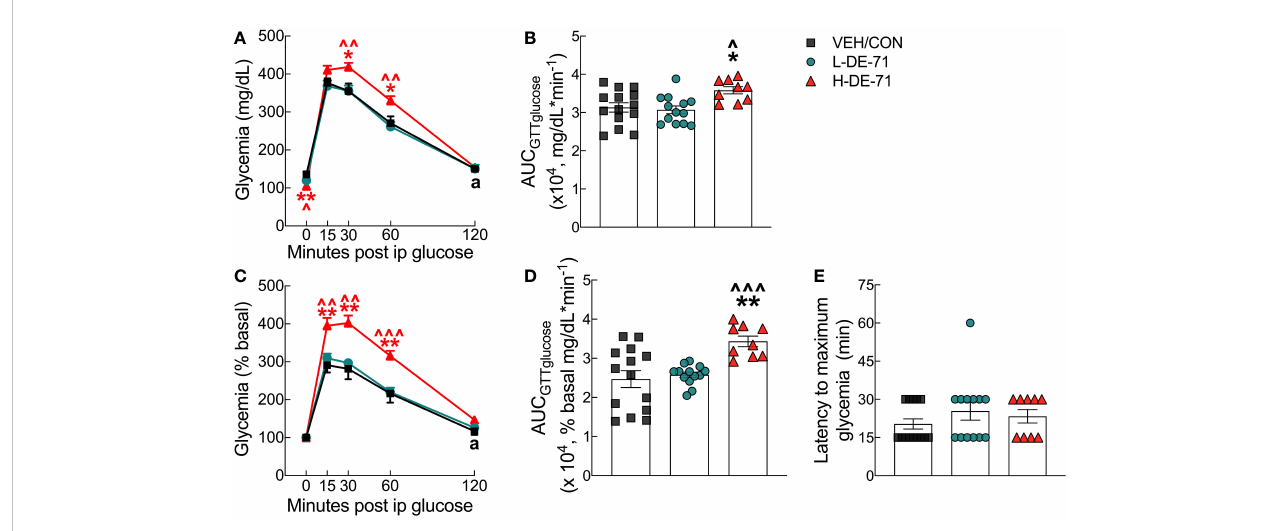
FIGURE 3 Glucose tolerance pro fi le in male mice offspring receiving perinatal exposure to DE-71. Mice were fasted for 11 h ON and tail blood was sampled for glucose before (t=0 min) and after (t=15, 30, 60 and 120 min) i.p. injection of 2.0 g/kg glucose. (A) Absolute blood glucose concentrations taken during IPGTT. (B) Mean values for the integrated area under the IPGTT glucose curve using absolute values (AUC GTTglucose ). (C) Blood glucose values taken during IPGTT are plotted vs time as a percent of basal glucose. (D) Mean values for the integrated area under the IPGTT glucose curve using percent baseline values (AUC GTTglucose ). (E) Latency to maximum glycemia corresponding to percent basal. Asterisk of speci fi c color indicates signi fi cant difference between corresponding group and VEH/CON (* p <0.05, ** p <0.01). Carets of speci fi c color indicate signi fi cant difference between corresponding group and L-DE-71 (^ p <0.05, ^^ p <0.01, ^^^ p <0.001). The black symbol “ a ” in panels (A, C) indicates the time points at which glycemia is not different from basal (t=0) in the VEH/CON group. Glycemia at all other time points and groups differs from basal. Bars and error bars represent values expressed as mean ± s.e.m. n , 9-14/group.